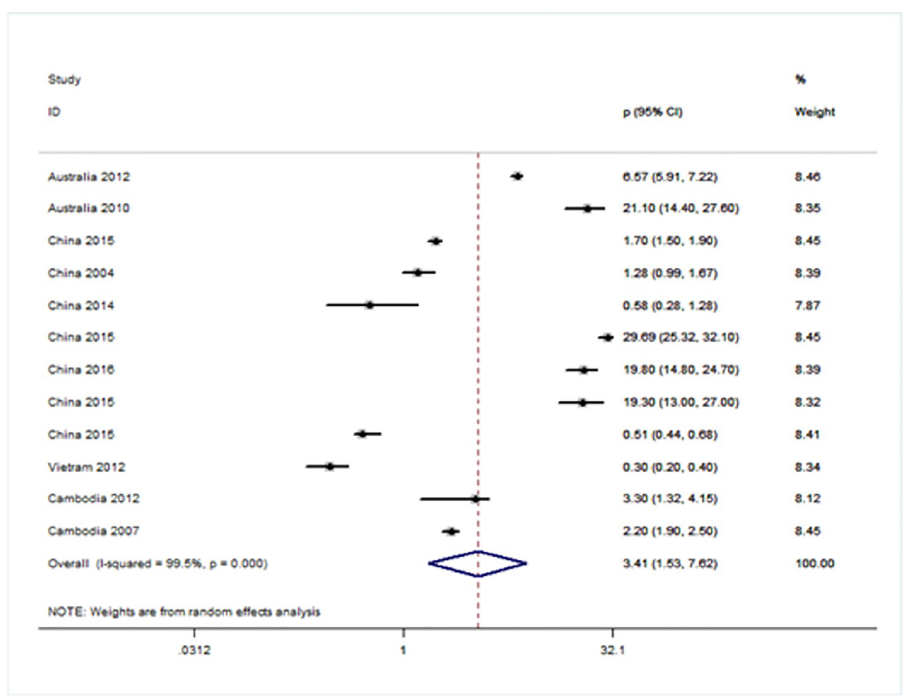
Fig 5. Forest plot showing prevalence of refractive errors among children aged < 20 years in Western Pacific region.